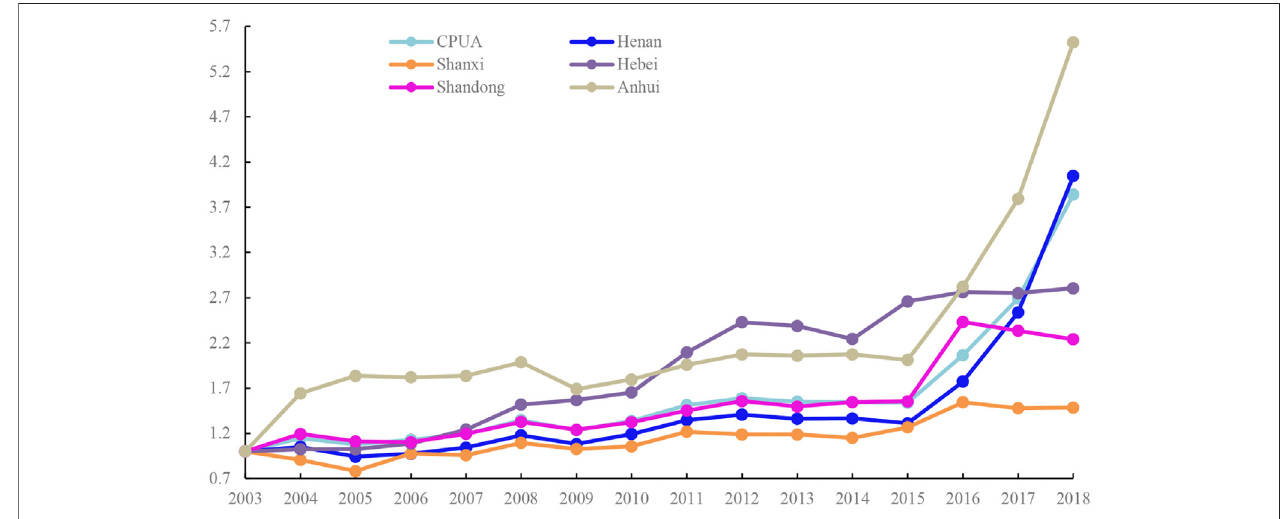
FIGURE 2 | Cumulative GTFP in the CPUA and sub-regions from 2003 to 2018.